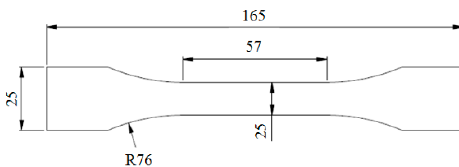
Figure 6. Specimen shapes and dimensions (mm) in accordance with ASTM D638.